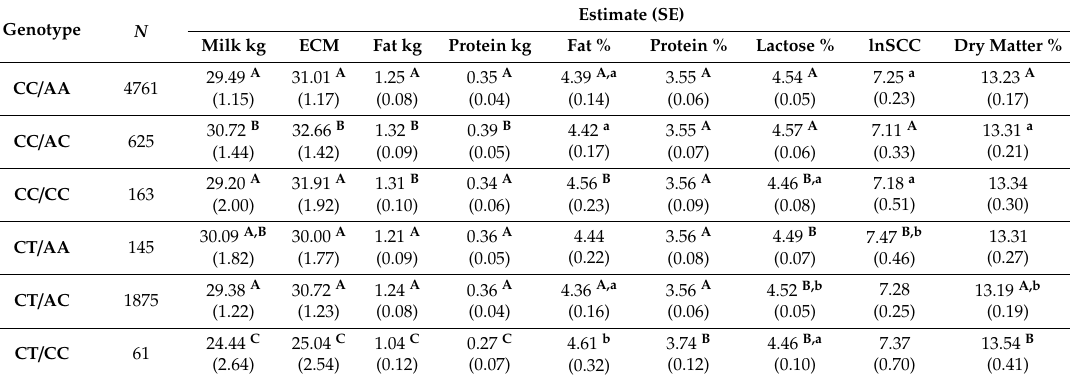
Table 1. The estimates and their standard errors (SE) of defensin genotypes for the investigated traits in daily tests.